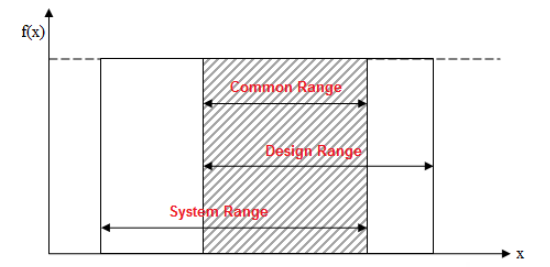
Fig. 1. Definition of design range, system range and common range 37